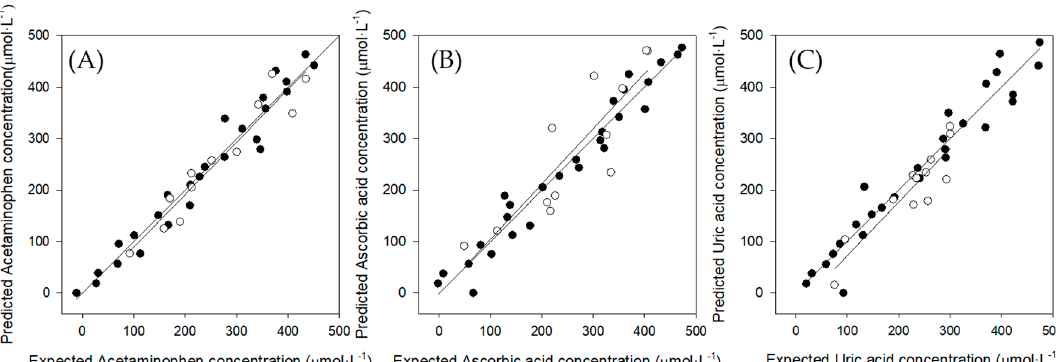
Figure 10. Obtained vs. expected concentrations results plots for the training set (black dots) and the testing set (white dots) for ( A ) Acetaminophen, ( B ) Ascorbic acid and ( C ) Uric acid.